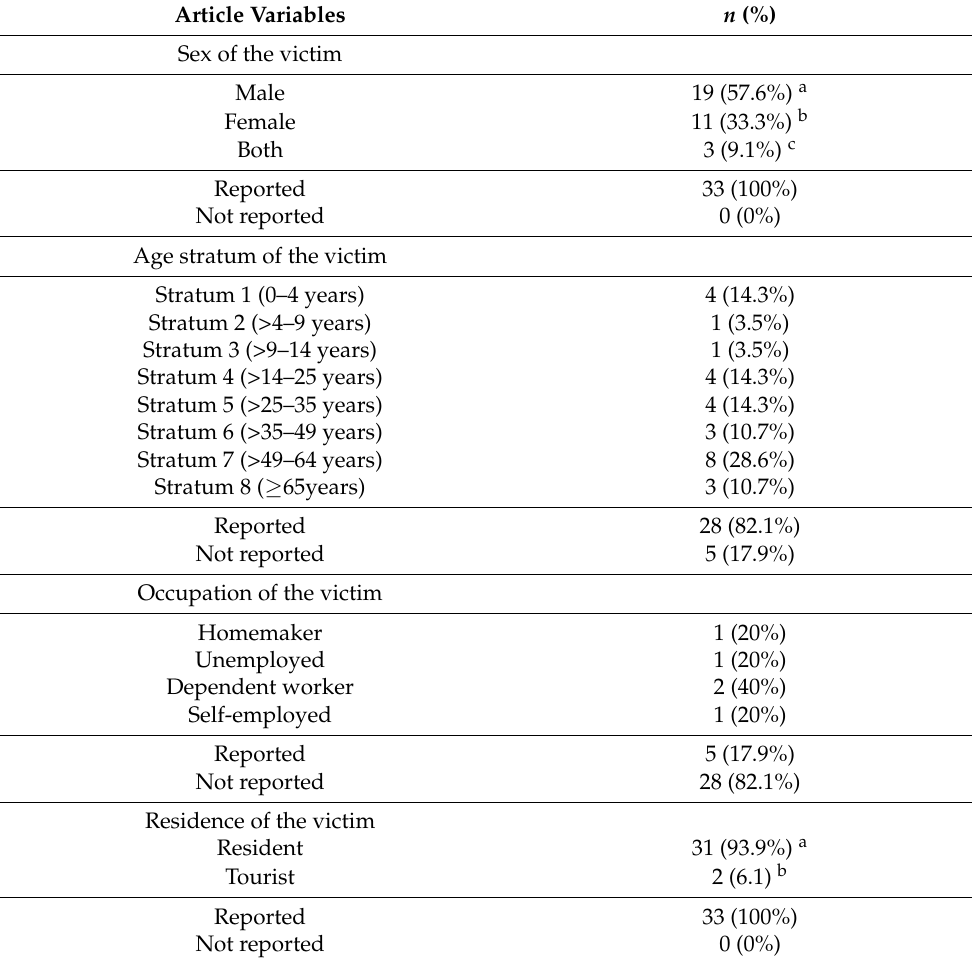
Table 4. Characteristics of the victim, collected from 33 articles on dog bites resulting in